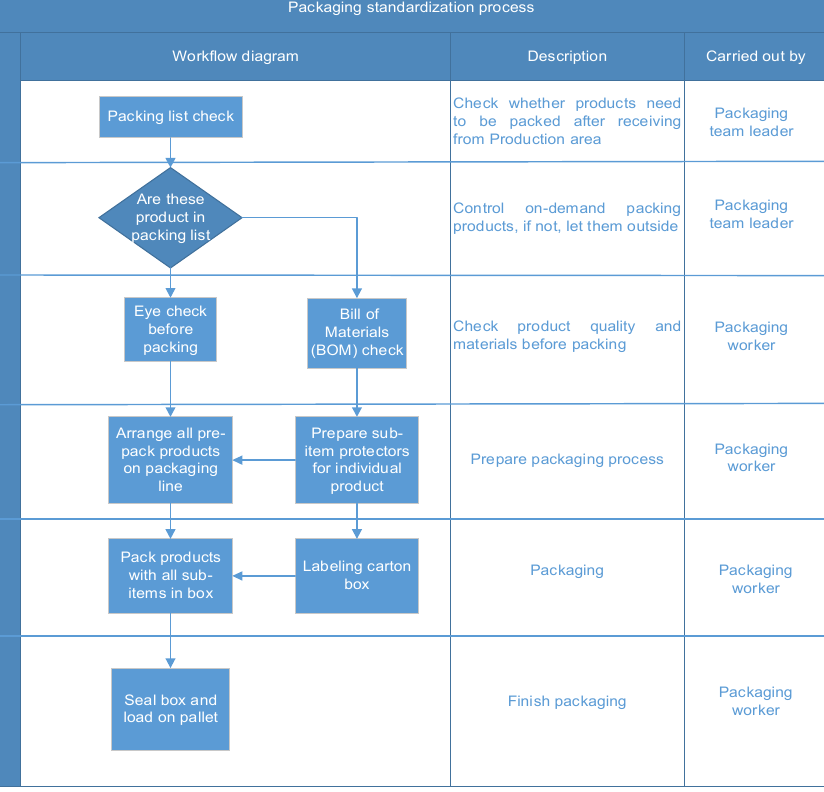
Figure 6. An example of a packaging standardization process.